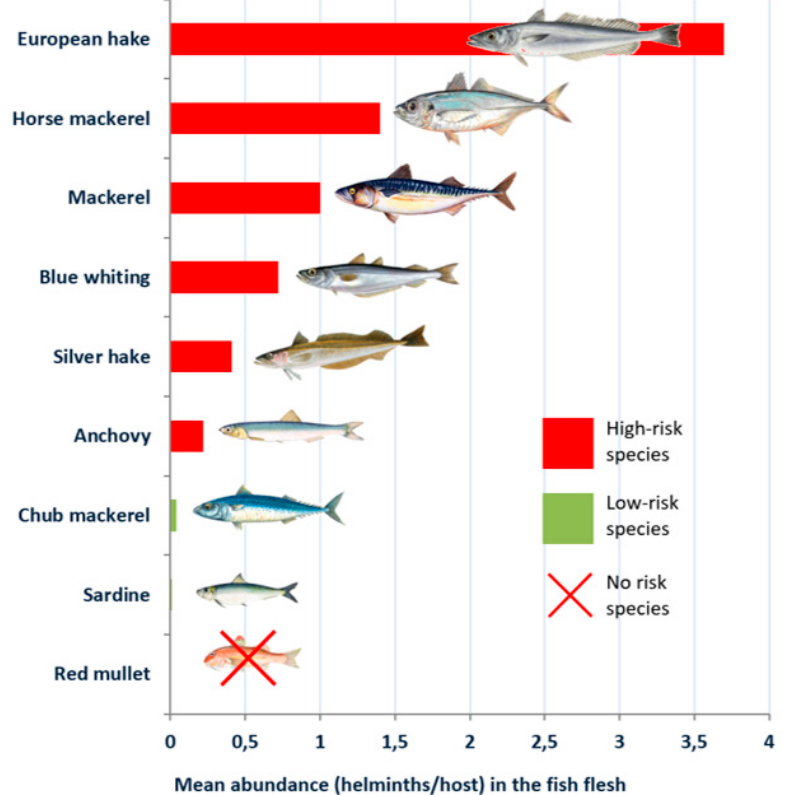
Figure 2. Classification of the fish species based on the mean abundance (helminths/host) of Anisakis type I larvae observed in the fish